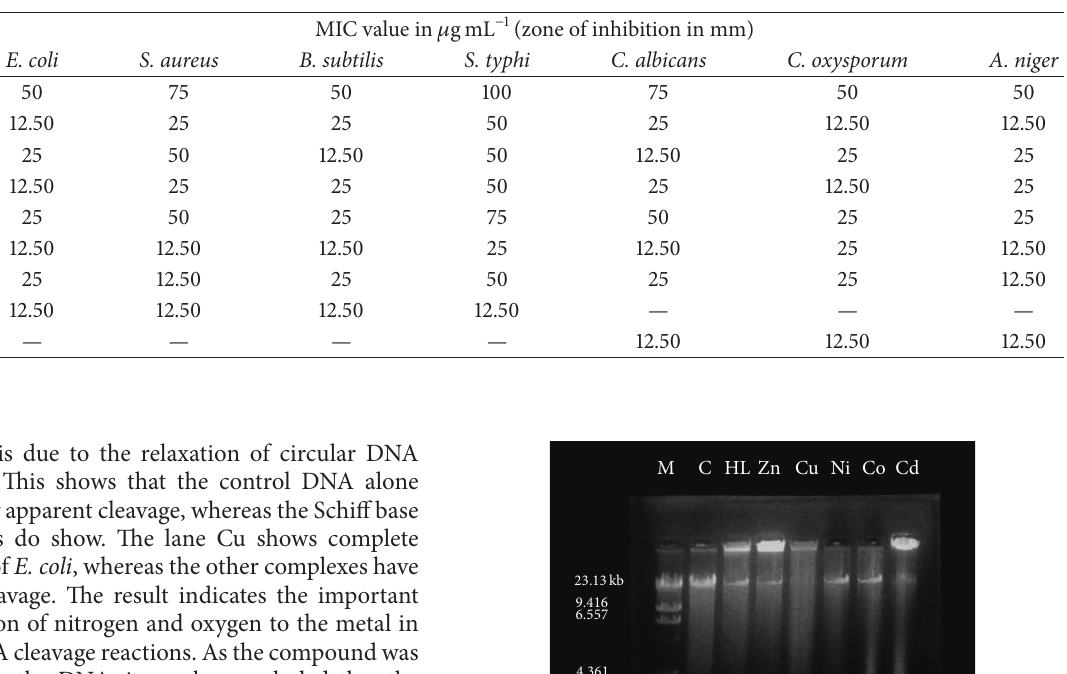
Table 8: Minimum inhibitory concentration (MIC 𝜇 gmL − 1 ) of ligand and its metal complexes.